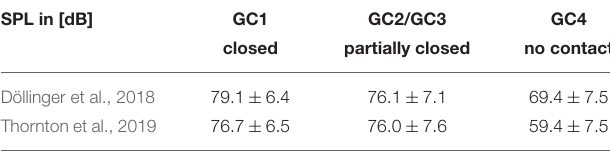
TABLE 3 | SPL in [dB] of Döllinger et al. (2018) and Thornton et al.